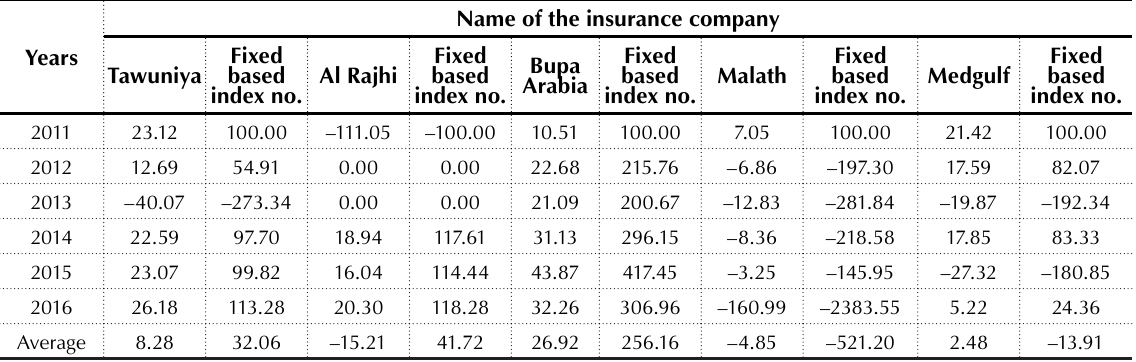
Table 4. Return on equity (ROE) (ratios are in percentage)